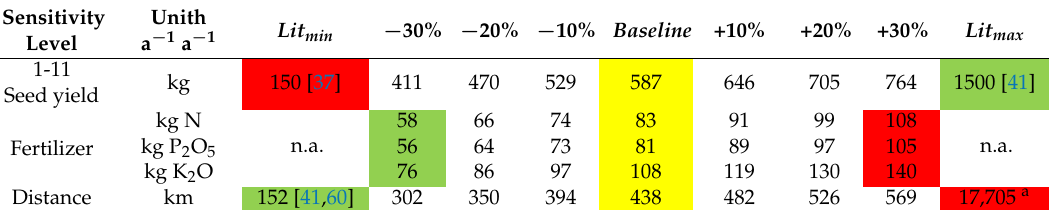
Table 5. Values of key inventory variables used for the sensitivity analysis of rubber seed yields, fertilizer levels, and transport distances ( best-case scenario marked in green, worst-case scenario marked in